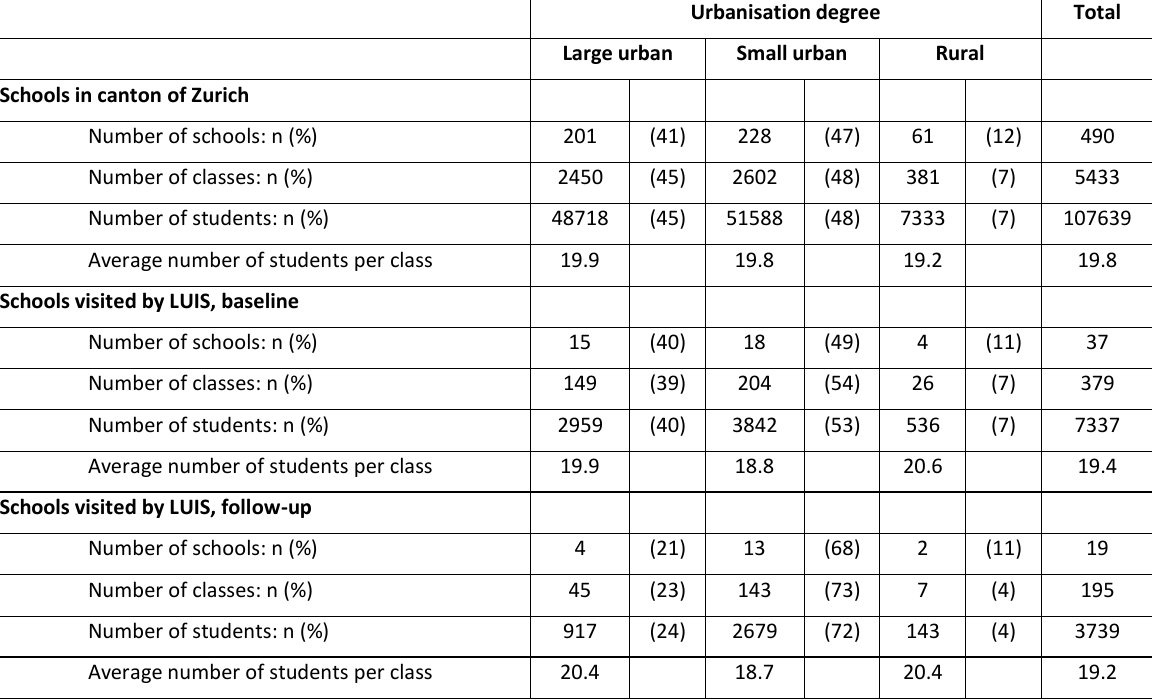
Table S1: Characteristics of schools in the canton of Zurich and visited by the LuftiBus in the school study (LUIS) at baseline and at one-year follow-up, by degree of